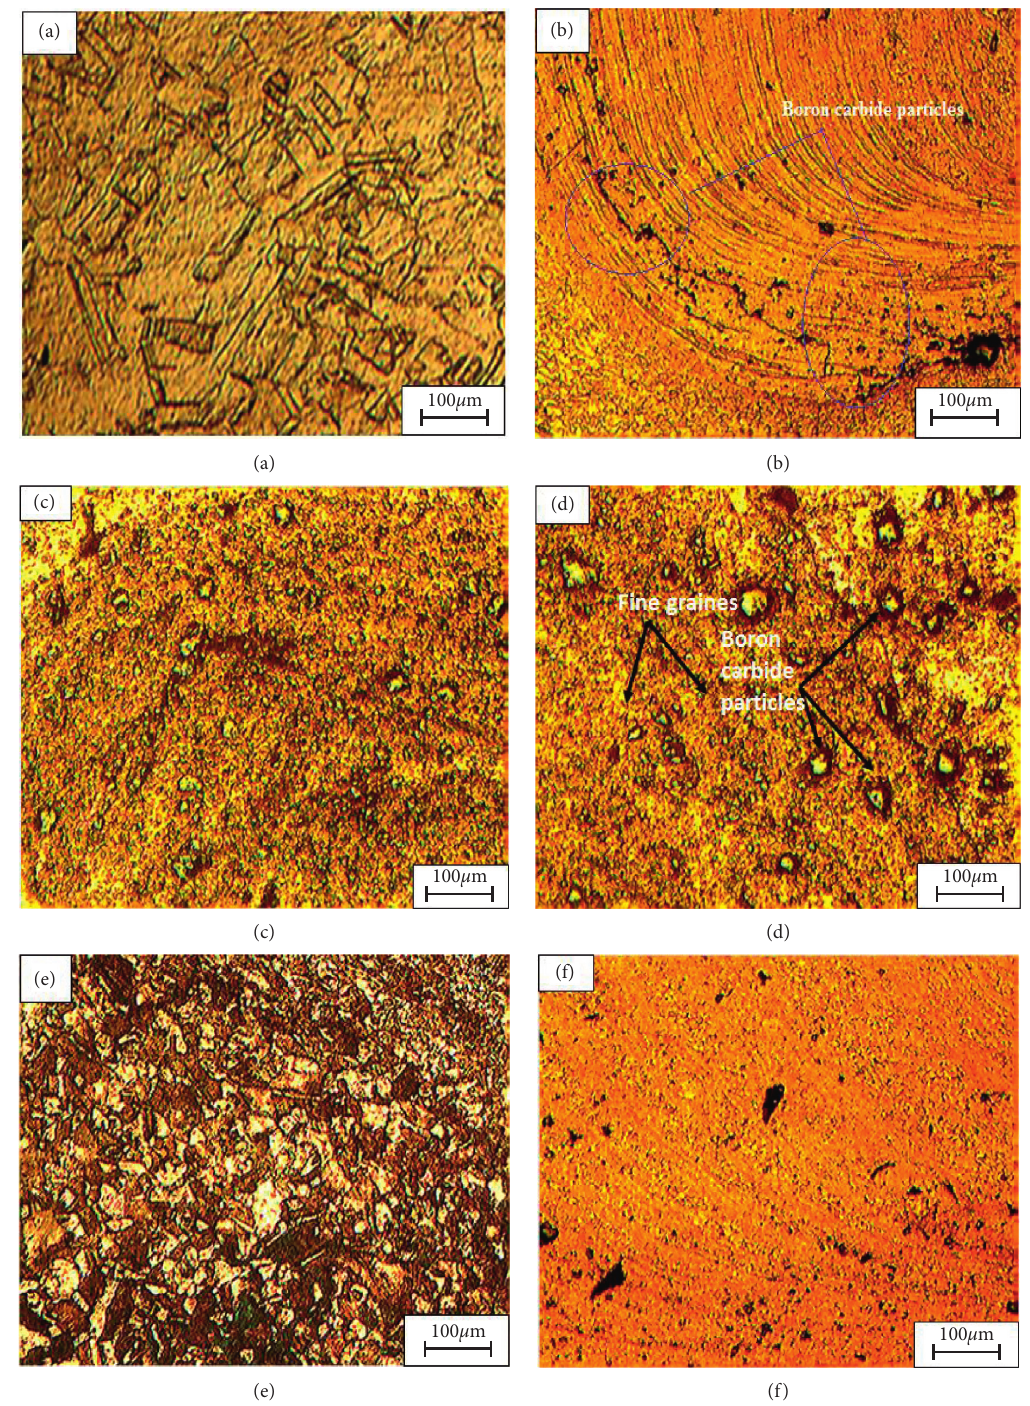
Figure 6: (a) Microstructure of the base copper material. (b–d) Copper-copper interface region and nugget zone inclusion of 3wt% of B particles. (e) Copper-copper nugget zone without B 4 C particles added. (f) Low amount of filled B 4 C at nugget